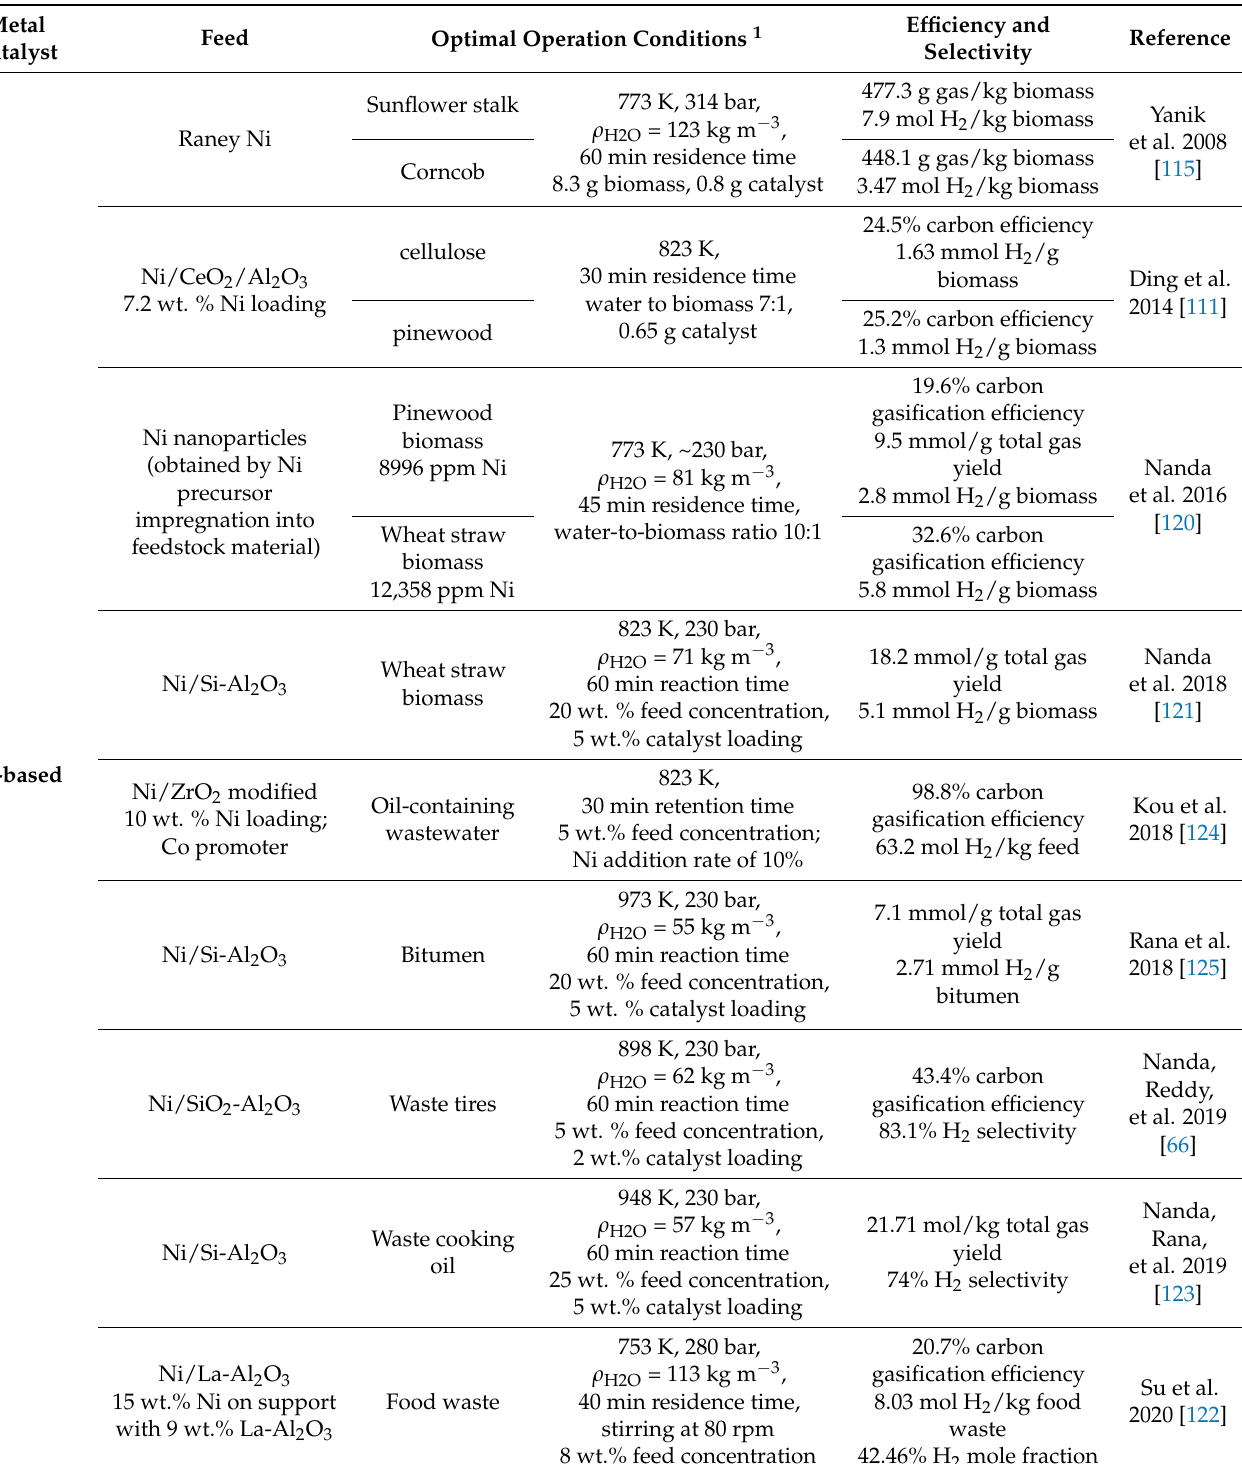
Table 1. Metal-based catalysts used for SCWG of waste; there are three categories of metal-based materials included in this table, namely Ni-based, noble metals and bimetallic catalysts.